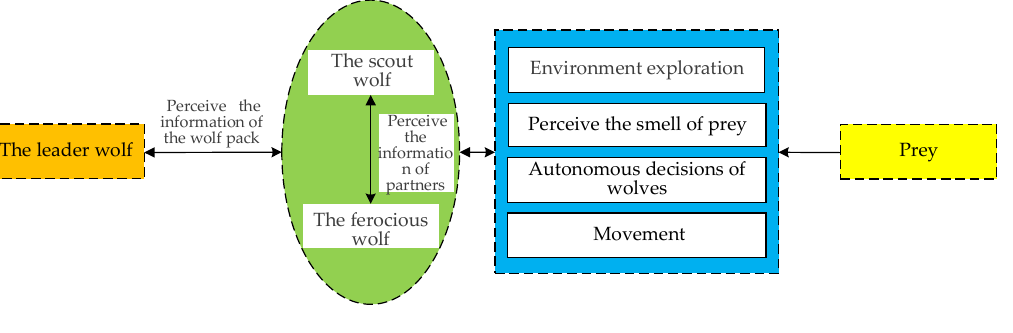
Figure 5. Bionic graph of WPA.